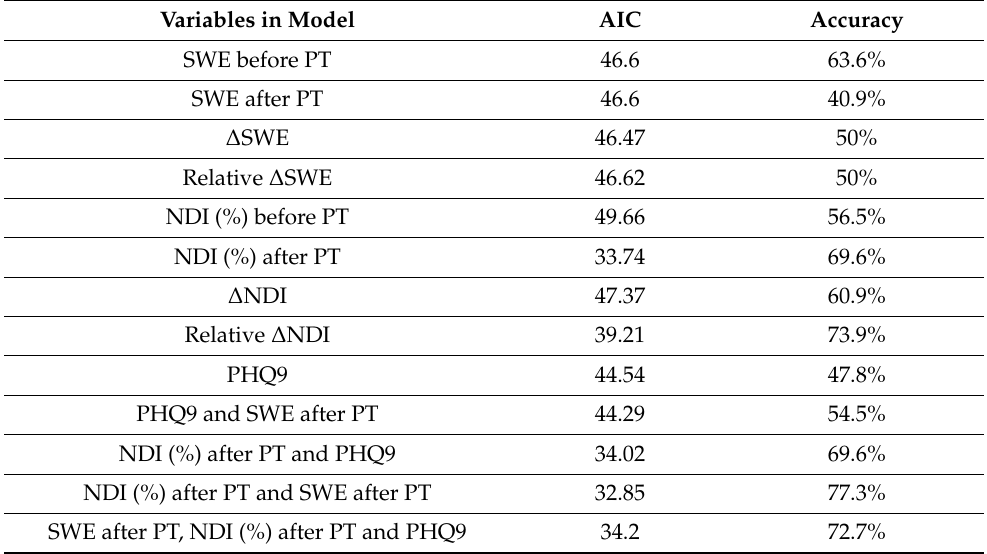
Table 4. Models predicting patient-perceived